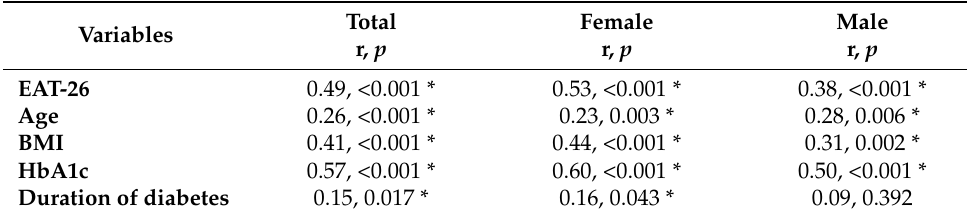
Table 2. Correlations of DEPS-R total score to other variables.